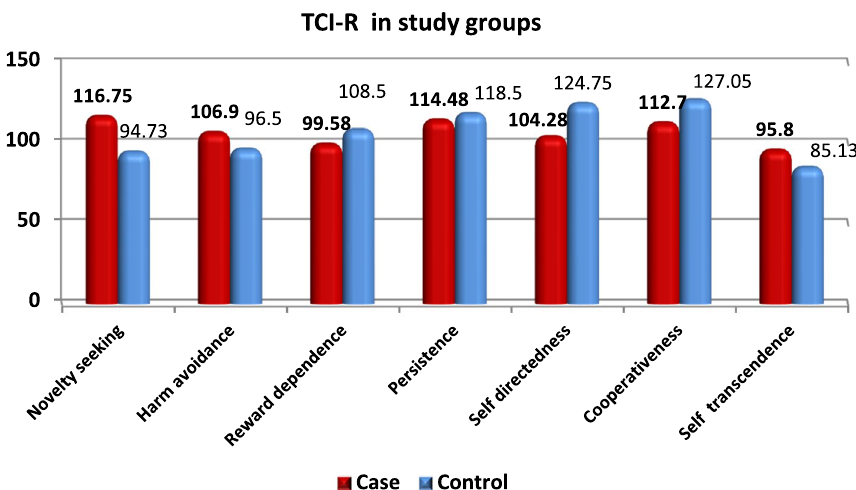
Fig. 2 Temperament and character inventory revised scale in the studied